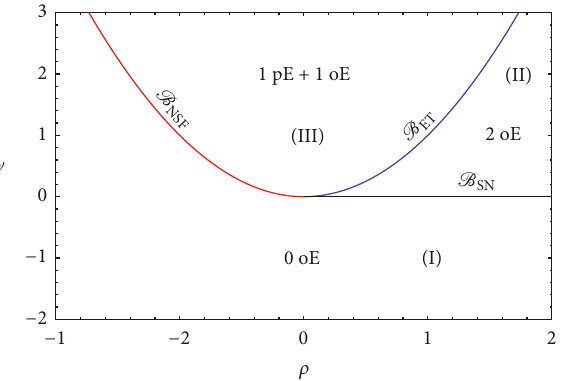
Figure 2: Bifurcation diagram of 𝑍 (20a), (20b), (20c), and (20d) in the (𝜌, ] ) -plane when 𝛿 = 𝜎 = −1 .